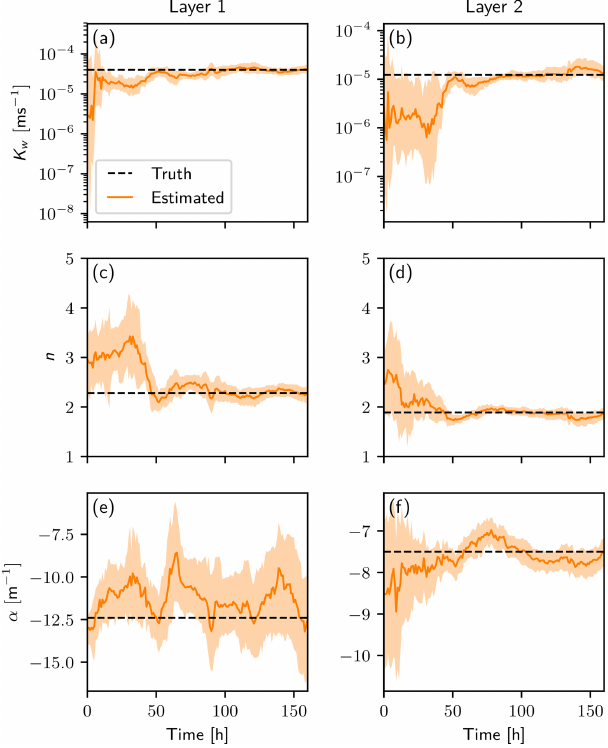
Figure 5. Estimation of all six parameters ( a : K w, 1 ; b : K w, 2 ; c : n 1 ; d : n 2 ; e : α 1 ; and f : α 2 ) over time. The ensemble mean is shown in orange, and the 95% quantile of the ensemble is shown in light orange. The truth is a black dashed